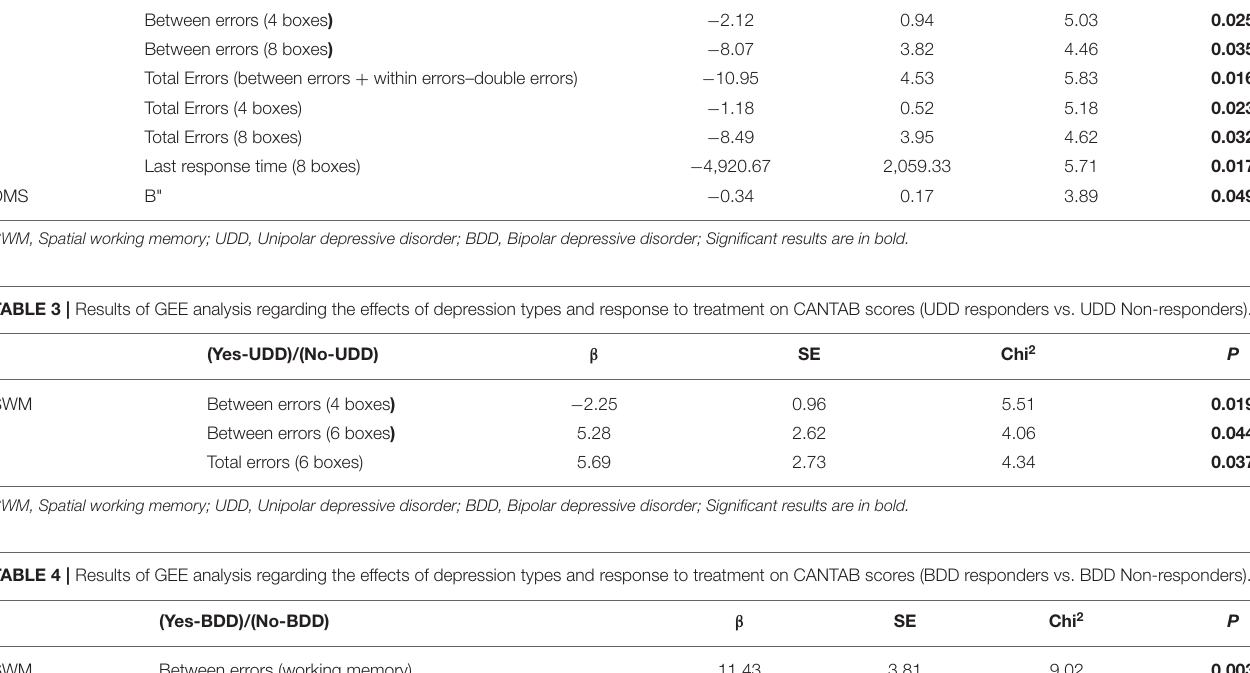
TABLE 2 | Results of GEE analysis regarding the effects of depression types and response to treatment on CANTAB scores (UDD responders vs. BDD responders). (Yes-UDD)/(Yes-BDD) β SE SWM Between errors (working memory) Between errors (4 boxes ) Total Errors (between errors + within errors–double errors)